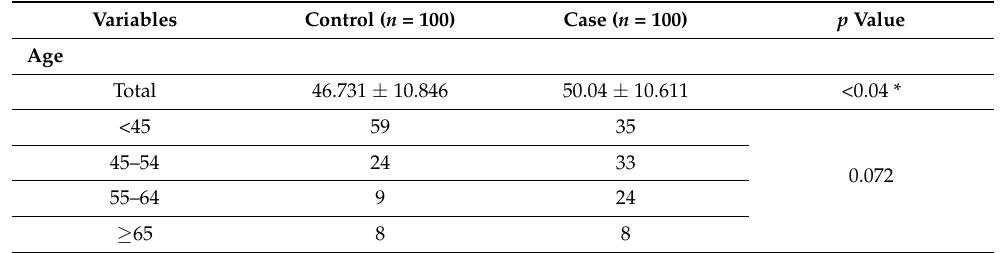
Table 1. Demographic characteristics of the study